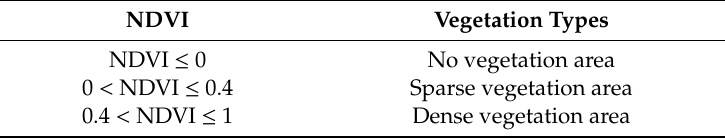
Table 5. Decision rules used for classifying the area. Normalized di ff erence vegetation index